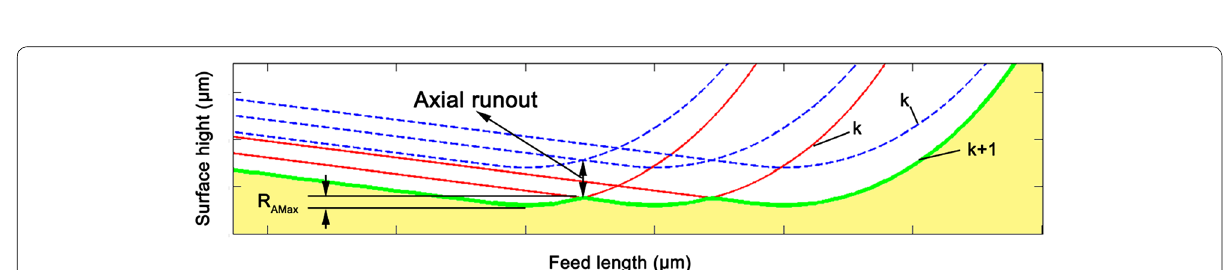
Figure 5 Influence of axial runout on surface generation